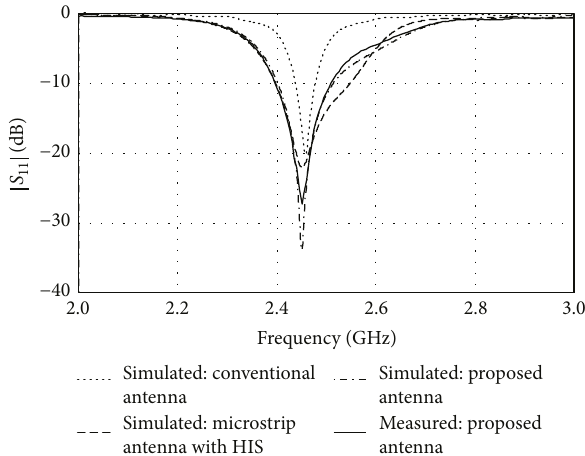
Figure 14: The simulated and measured | S